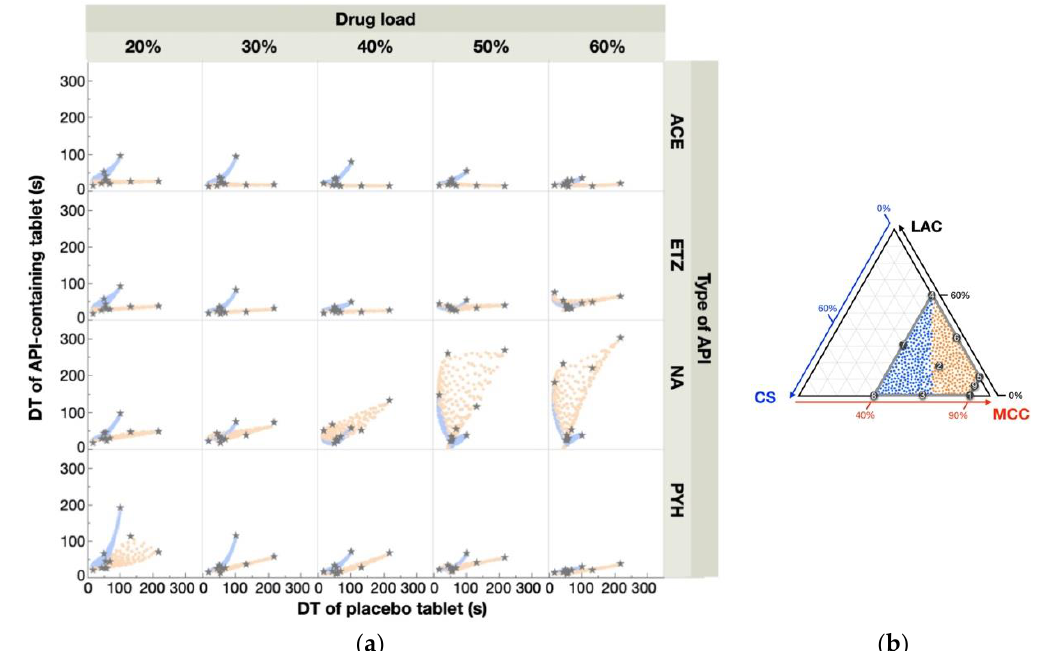
Figure 5. Relationships between the response surface for DT of placebo- and API-containing tablets. A scatterplot matrix ( a ) shows the relationships of DTs between placebo- and API-containing tablets. Gray stars represent experimental data points. Blue and orange points shown in the scatterplots correspond to DTs of untested formulations randomly selected from the left and right halves of the response surface ( b ).